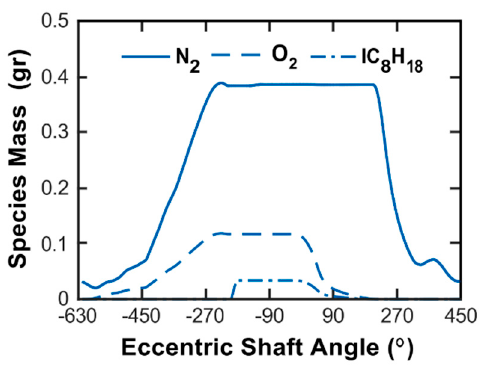
Figure 3. Simulated mass of nitrogen (N 2 ), oxygen (O 2 ), and iso-octane (IC 8 H 18 ) species in the baseline engine working chamber operating at 7550 RPM and WOT mode.